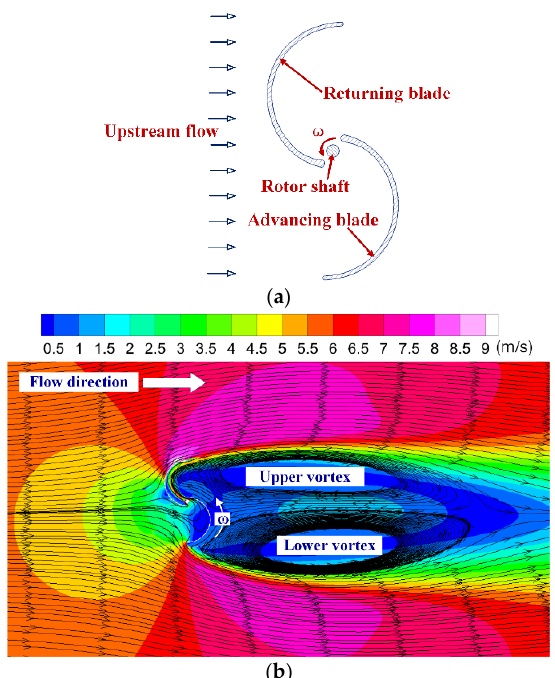
Figure 1. Conventional Savonius rotor . ( a ) Schematic view of the rotor ; ( b ) Cross-sectional flow pattern around the rotor.